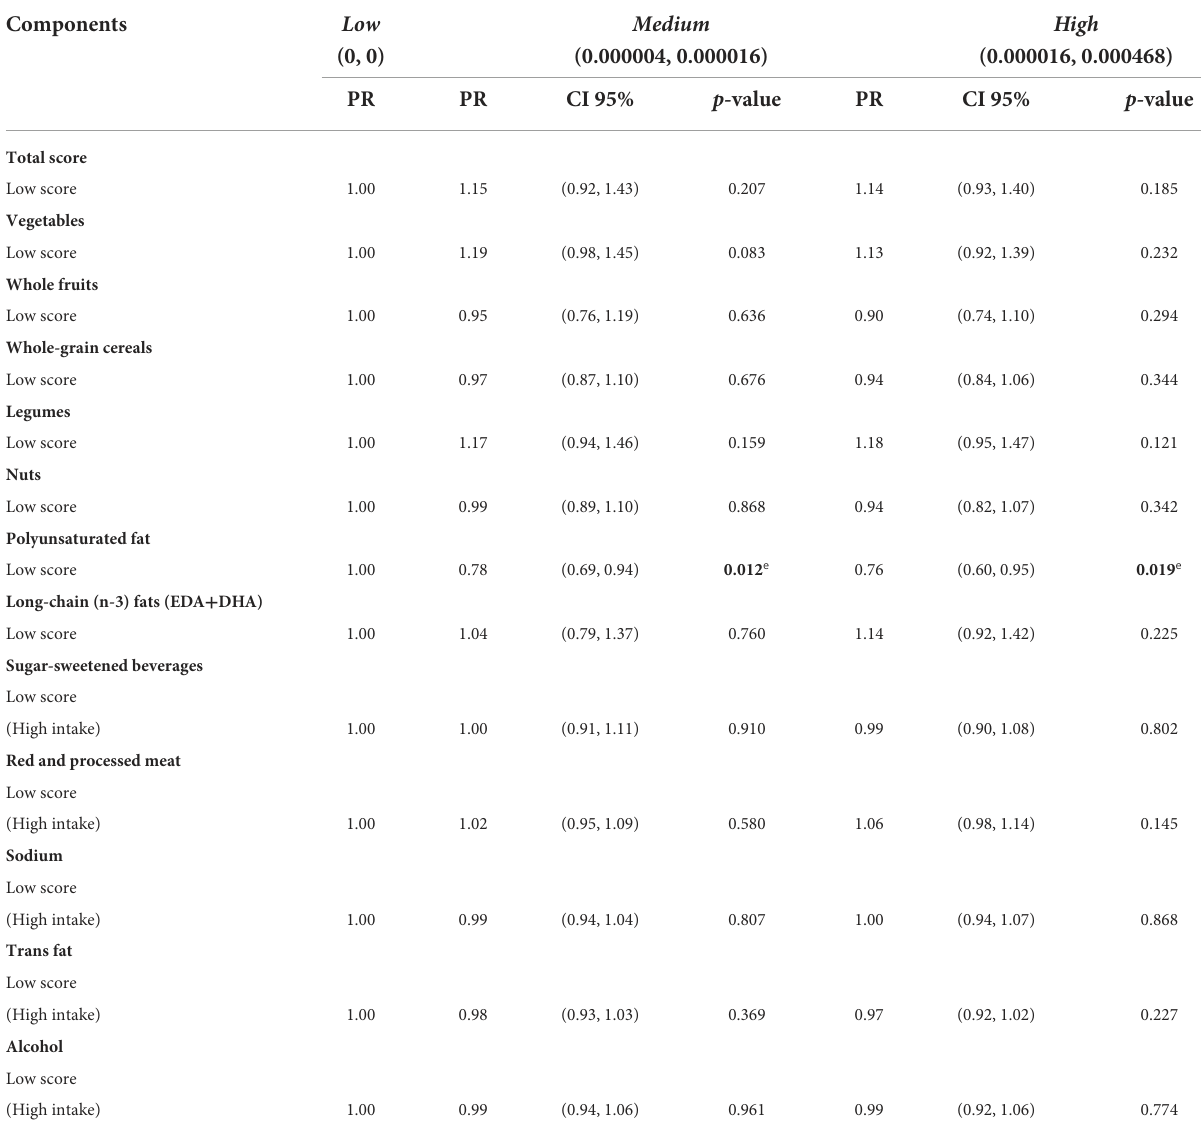
TABLE 4 Association between the density of convenience stores with Mexican Alternate Healthy Eating Index overall and components a . MxAHEI b Density of convenience stores per Euclidean buffer c